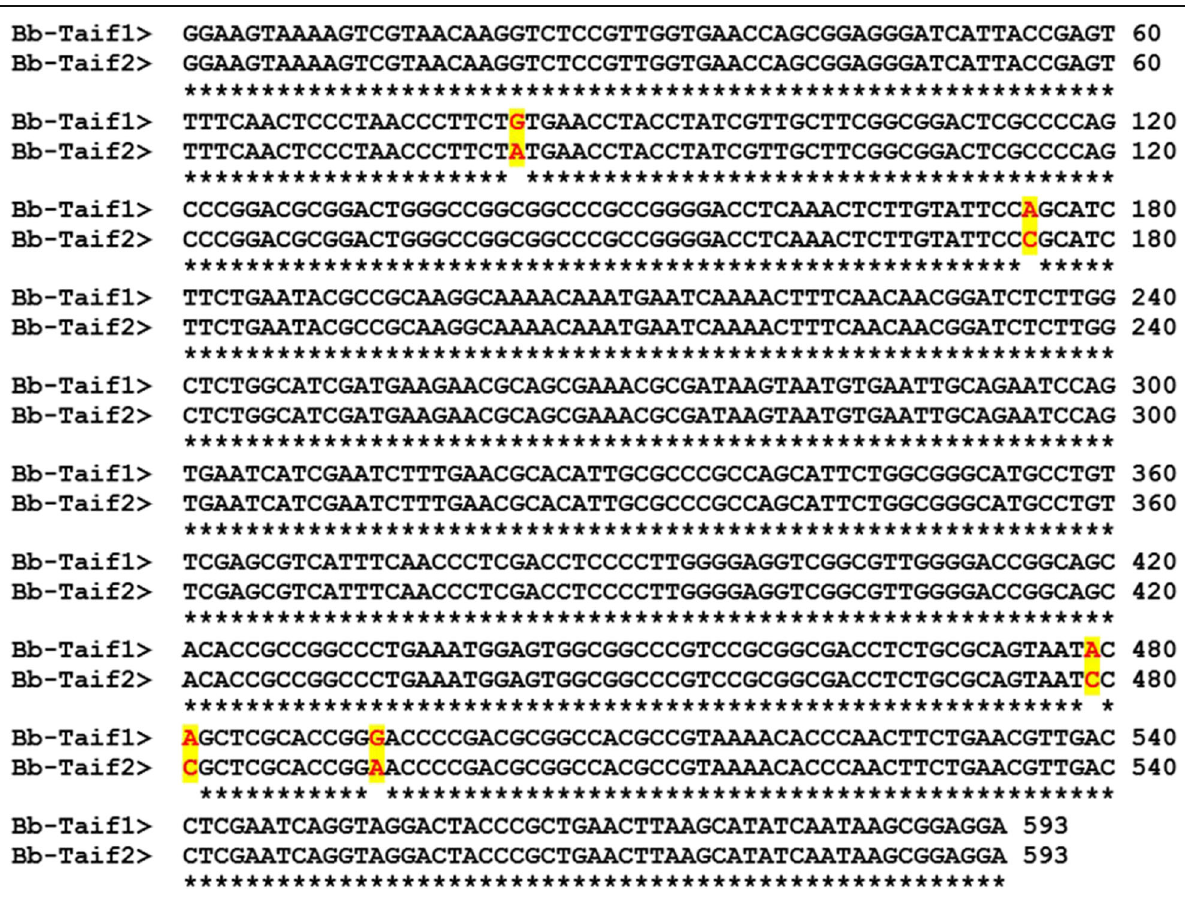
Fig. 3 Sequences of ITS region of 2 isolates of endophytic fungus, Beauveria bassiana with alignment of both. The single neoclutide polymorphism (SNP) with red and highlighted color while the sequence indicates genes as 18S-partial sequence (1 – 53), ITS1 (54 – 214),